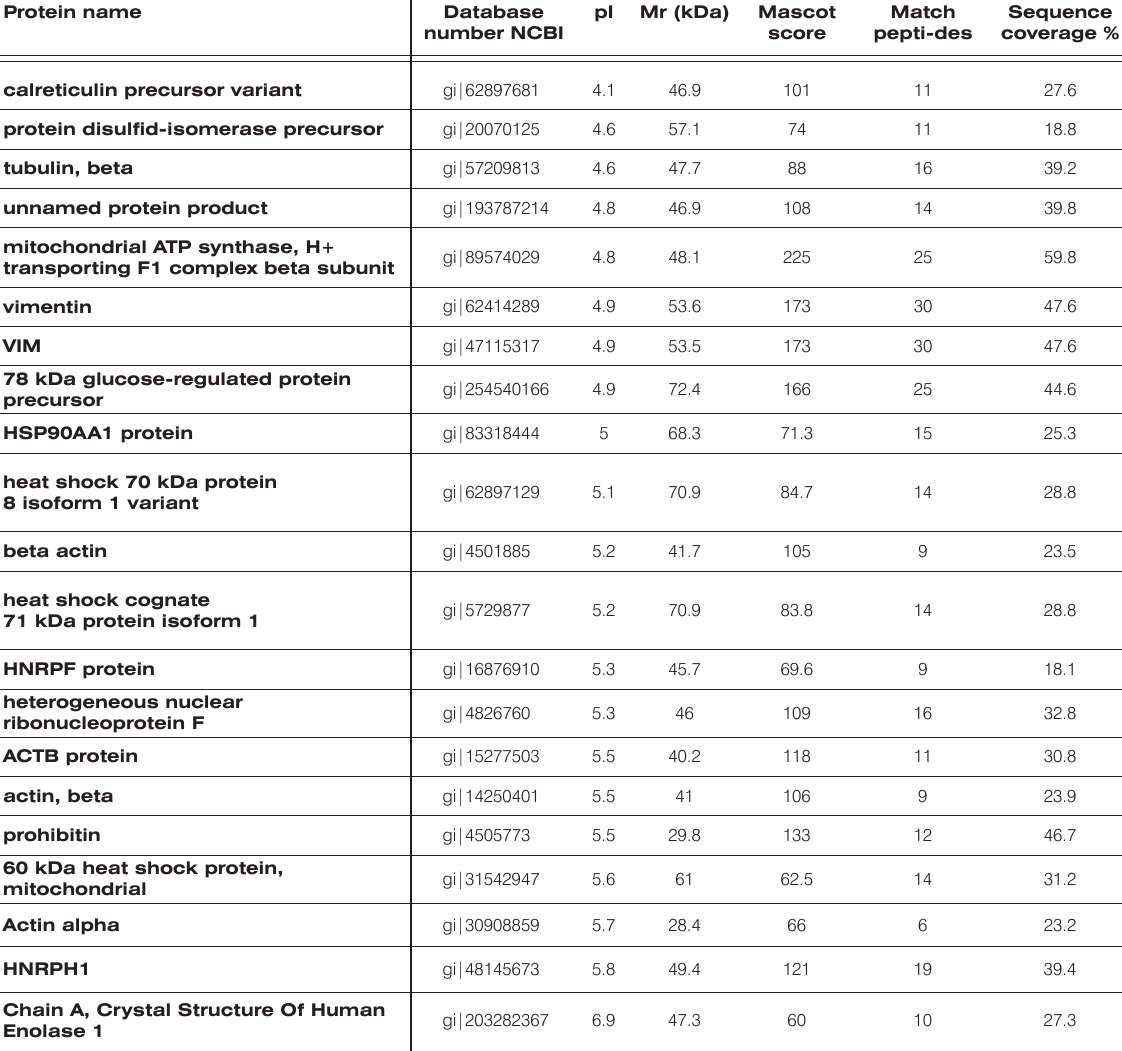
Table 1. Nuclear proteins of MCF-7 cells identified on 2-D patterns by